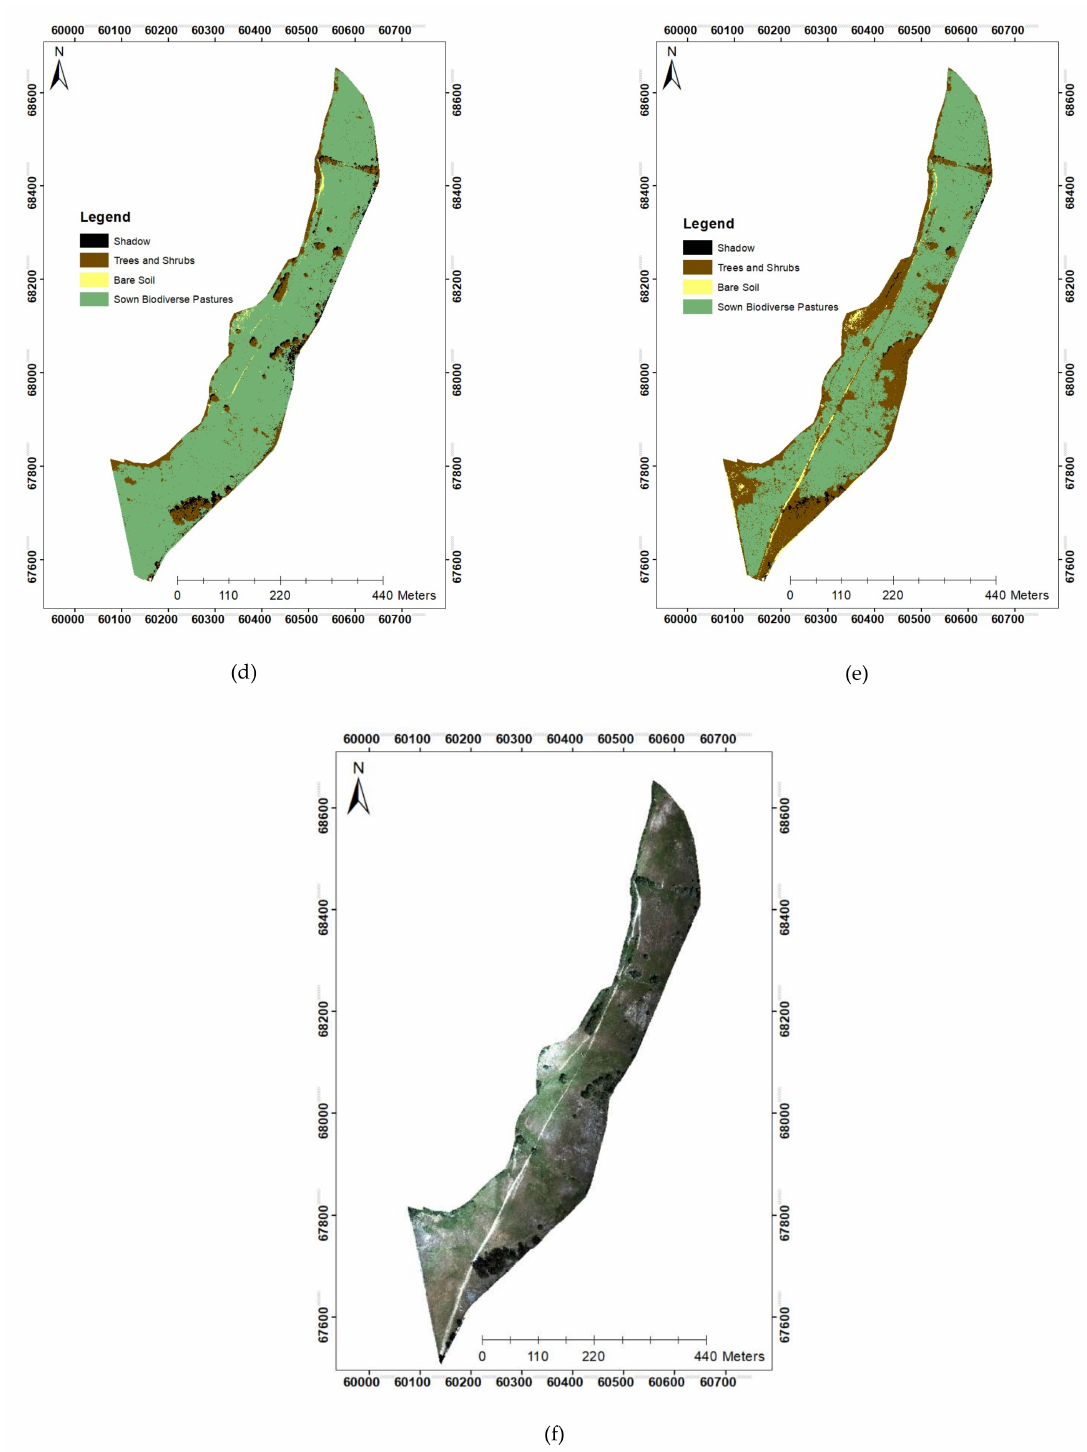
Figure A1. Land cover maps produced through single epoch classification using Support Vector Machines for farms 1 ( a ) and 2 ( d ), and using Artificial Neural Networks also for farms 1 ( b ) and 2 ( e ), as well as an aerial photograph of farm 1 acquired in the 7th of November, 2017 ( c ) and an aerial photograph of farm 2 acquired in the 15th of May, 2018 ( f